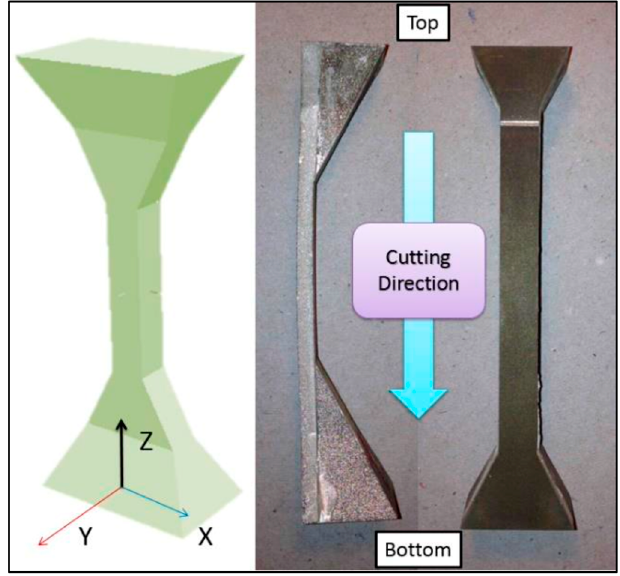
Figure 4. Test peg preparation and cuts for the contour method.